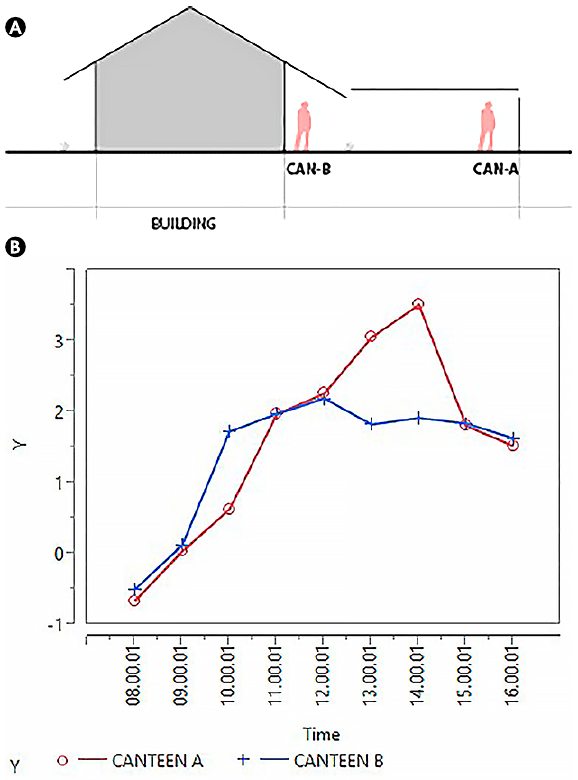
Figure 14. (a) Section of COR3A and COR3B (b) Comparison of PMV at 2 points location in the COR3 zone